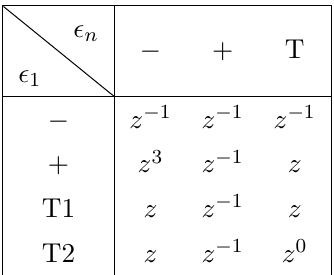
Table 1 . Large- z behaviour of the amplitude for di(cid:11)erent polarisations, with q arbitrary. Clearly, the boundary terms vanish if we align q = (cid:15) (cid:0) by (cid:15) T (cid:1) (cid:15) T 6 = 0 (T1), versus (cid:15) T n 1